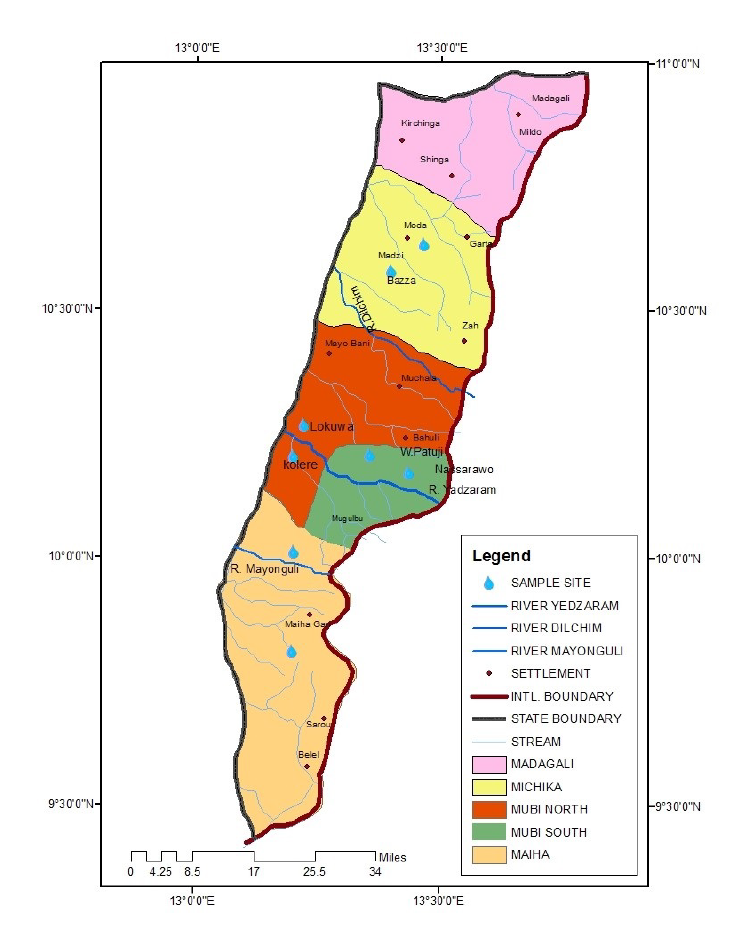
Figure 1. The study region of Adamawa-North senatorial zone of Adamawa State, Nigeria. Sampling sites were wells and river streams of Mubi North, Mubi South, Michika, and Maiha local government